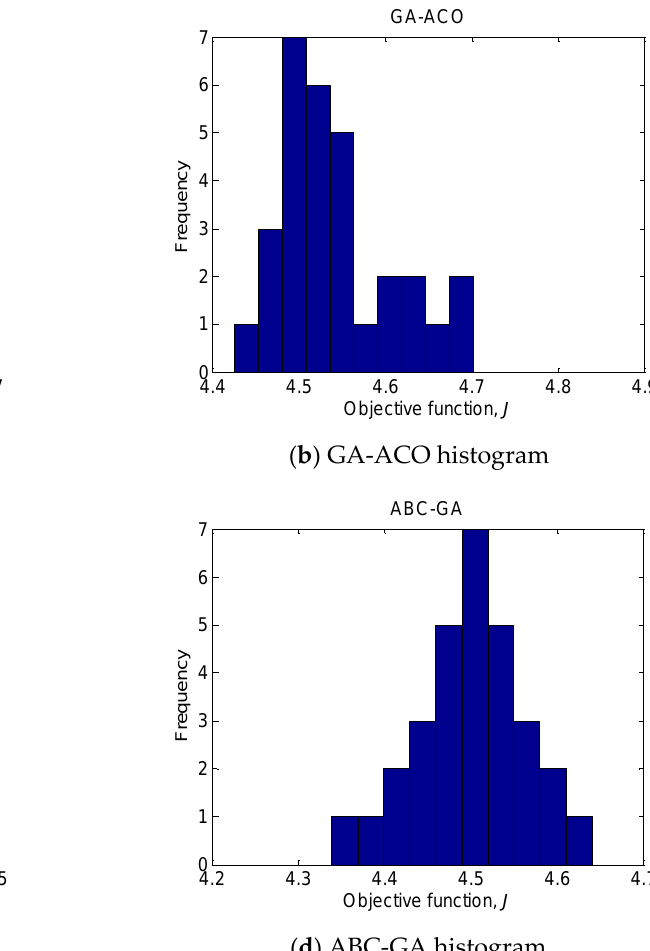
13 of 16 Table 7. Comparison of the objective function values obtained by ABC with the published ones. Algorithm